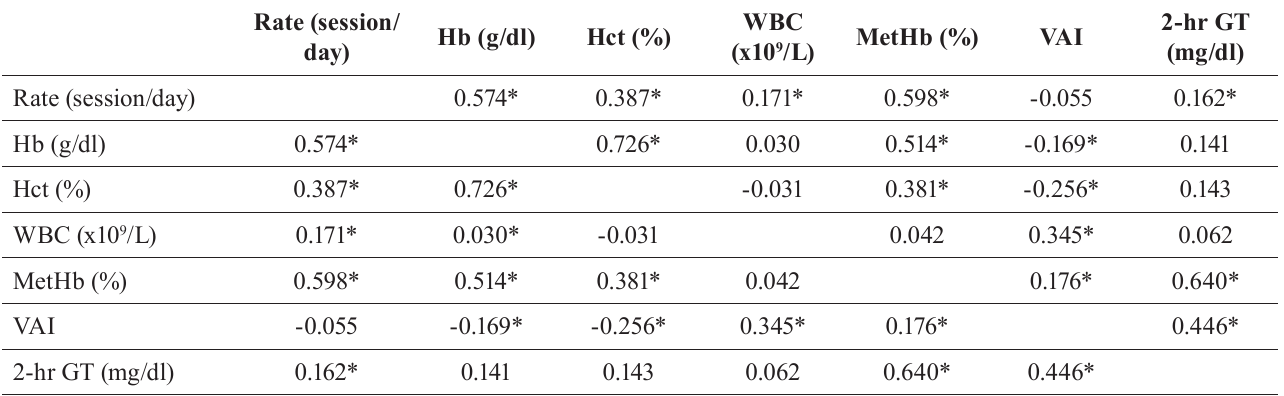
TABLE V - C orrelation ( r values) study between the rate of water-pipe smoking and some of the studied markers in water-pipe